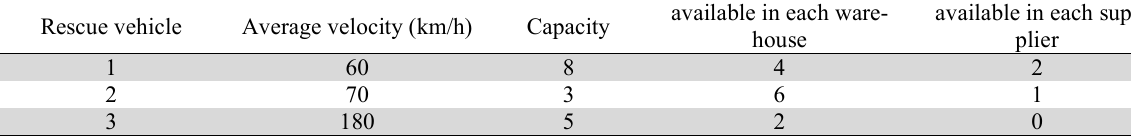
Rescue vehicles information